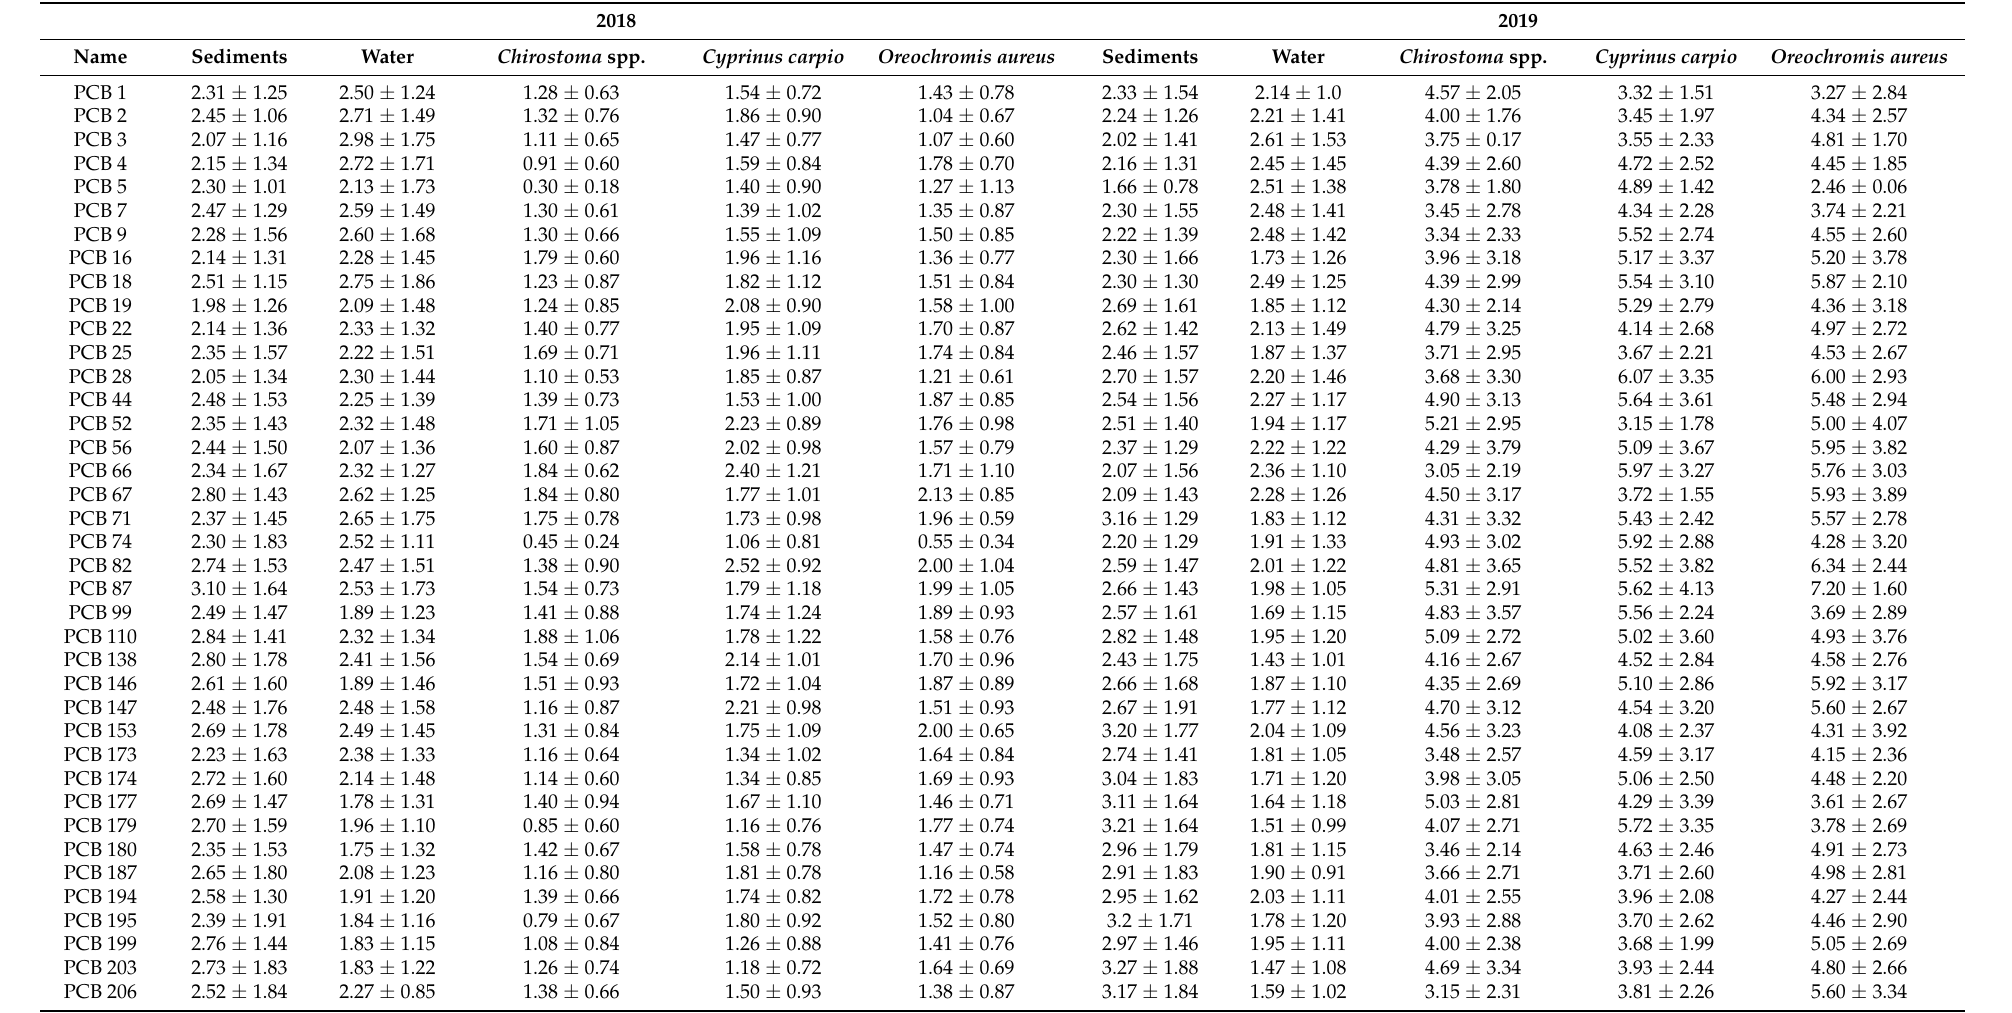
Table 2. PCBs concentrations in matrices of: sediments, water, and fish species from Lake